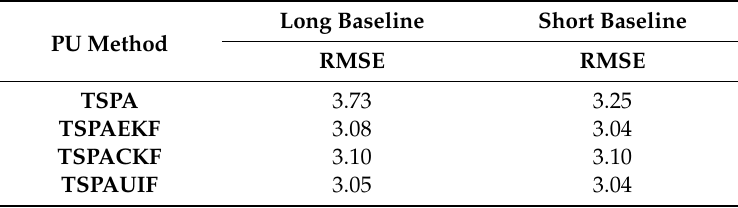
Table 5. Root mean-square error (RMSEs) of TanDEM-X DEM assessed using ICESat data points (unit: